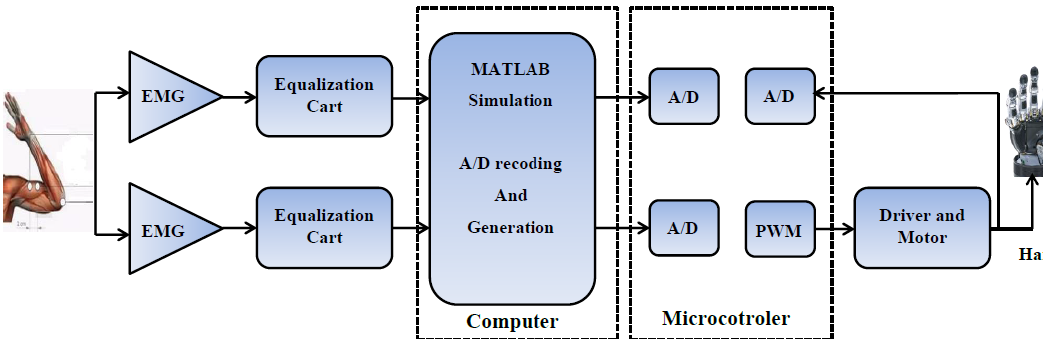
Figure 2. Block diagram of the control circuit of the prosthesis.